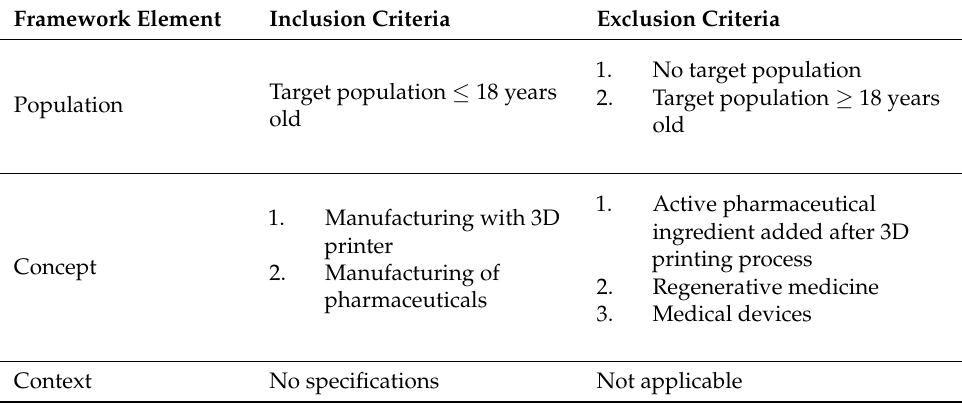
Table A1. In- and exclusion criteria of search